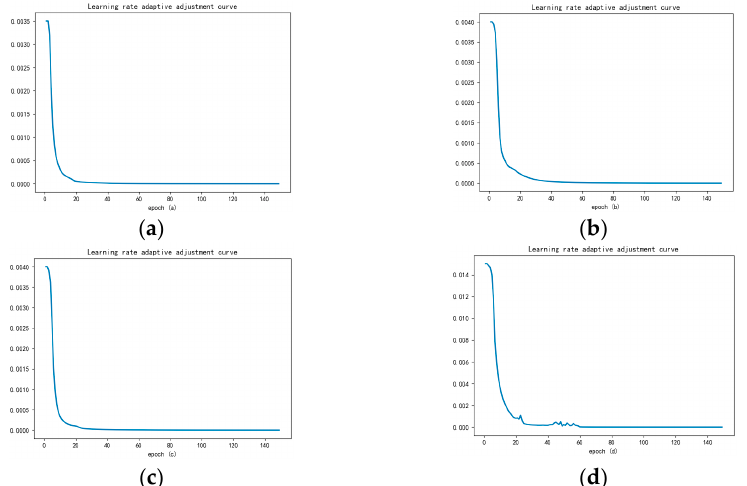
Figure 11. Model learning rate adjustment law: ( a ) 𝐴 − 𝐻𝐷𝐶𝑁𝑁 (cid:2869)(cid:2869) Model; ( b ) 𝐴 − 𝐻𝐷𝐶𝑁𝑁 (cid:2869)(cid:2870) Model; ( c ) 𝐴 − 𝐻𝐷𝐶𝑁𝑁 (cid:2870)(cid:2870) Model; ( d ) 𝐴 − 𝐻𝐷𝐶𝑁𝑁 (cid:2871)(cid:2870) Model.